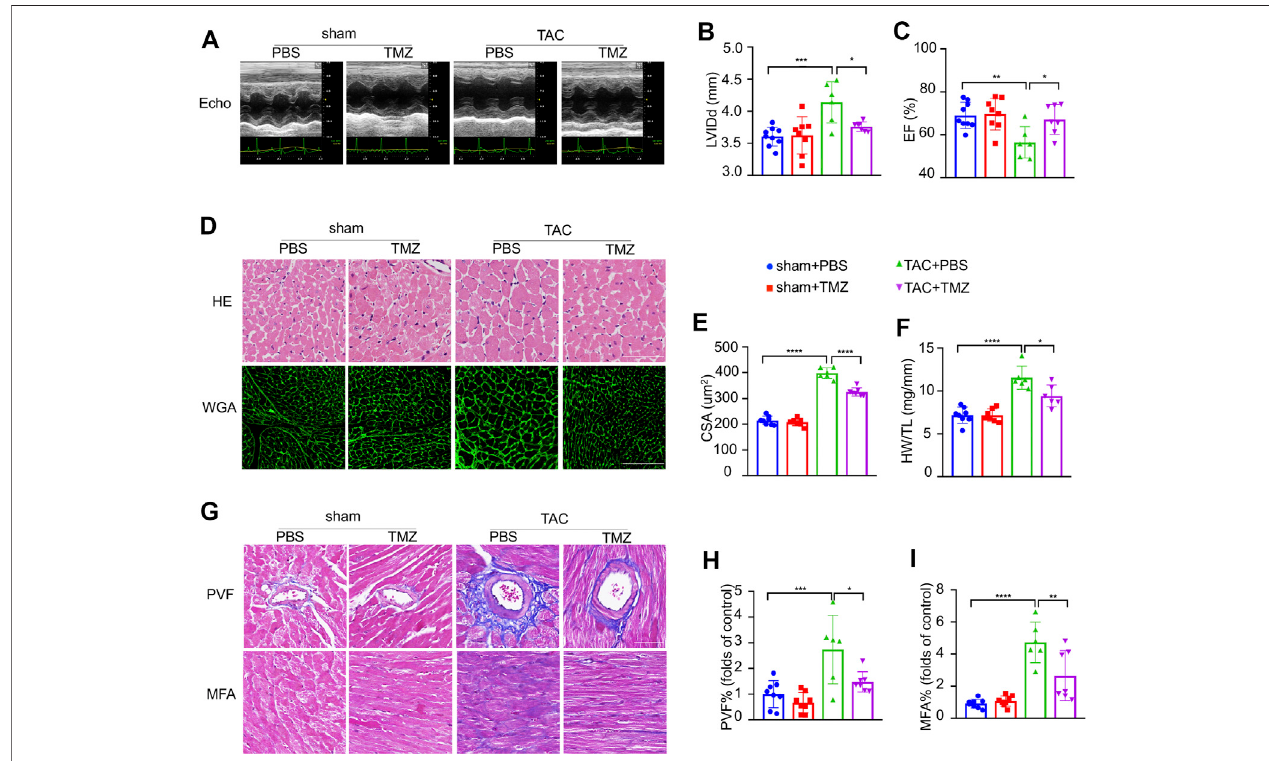
FIGURE 1 | Trimetazidine ameliorated pressure overload-induced heart failure. (A) Representative M-mode echocardiograms after transverse aortic constriction (TAC) or trimetazidine (TMZ) treatment. (B) Diastole for left ventricular internal diameter (LVIDd). (C) Left ventricular ejection fraction (EF). (D) Representative histological imagesofH&E(scalebar (cid:2) 100 um)andwheatgermagglutinin(WGA)staining(scalebar (cid:2) 100 um). (F) Leftventricularweight(LVW)totibialength(TL)ratio. (E) Relative across sectional area (CSA) of cardiomyocytes calculated from WGA staining. (G) Representative cardiac section stained with Masson ’ s trichrome (scale bar (cid:2) 100 um). (H,I) Quantitative results of perivascular fi brosis area (PVF) and myocardial fi brosis area (MFA). Graphical data are shown as mean ± SEM. One-way ANOVA was used for analysis. * p < 0.05, ** p < 0.01, *** p < 0.001, **** p < 0.0001, vs indicated